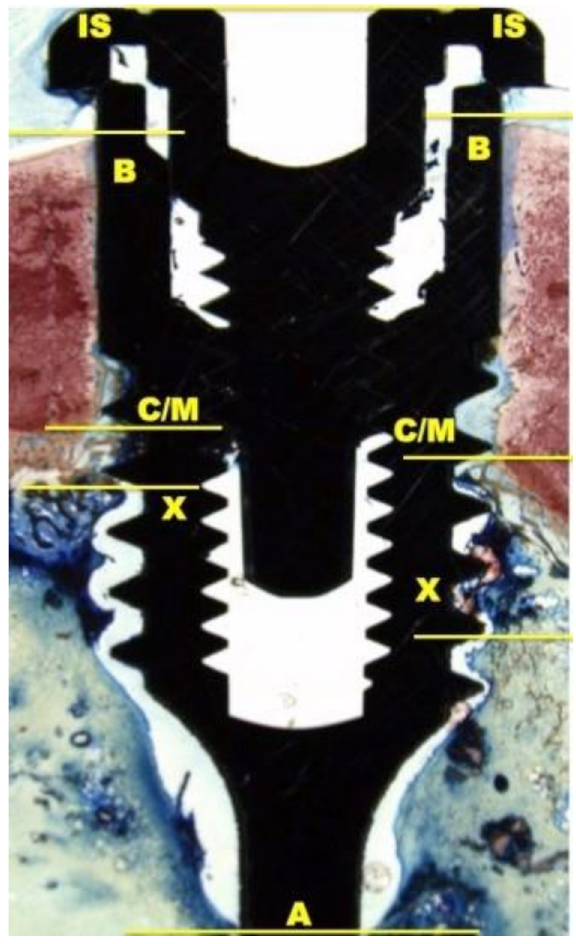
Figure 2. At 100 × magnification, landmarks scheme adopted for the histological measurements: Shoulder of the implant (IS), the most coronal bone-to-implant contact point (B), the intersection between cortical and marrow bone compartments (C/M), the most apical bone-to-implant contact point (X), and the apex of the implant